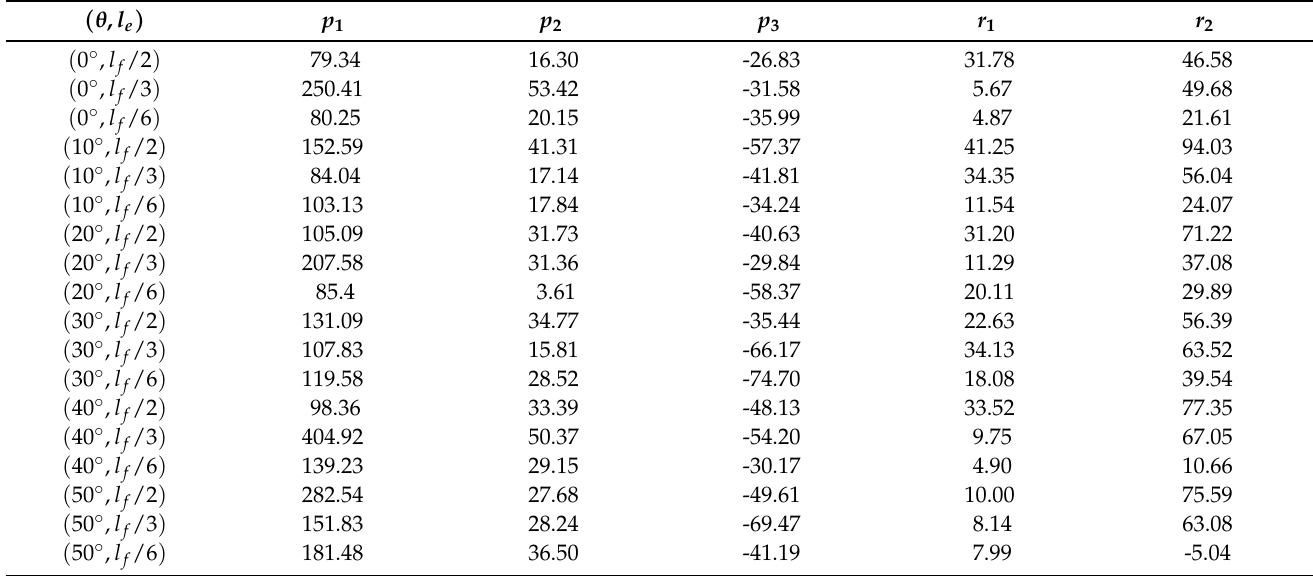
Table A2. Parameter values for P tri ( w , θ , l e ) . No value for p 1 was determined for the